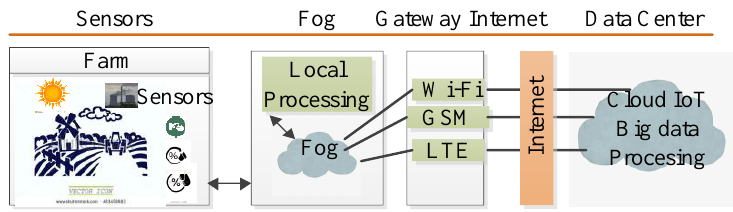
Figure 5. Real time CoT-based automated irrigation system.